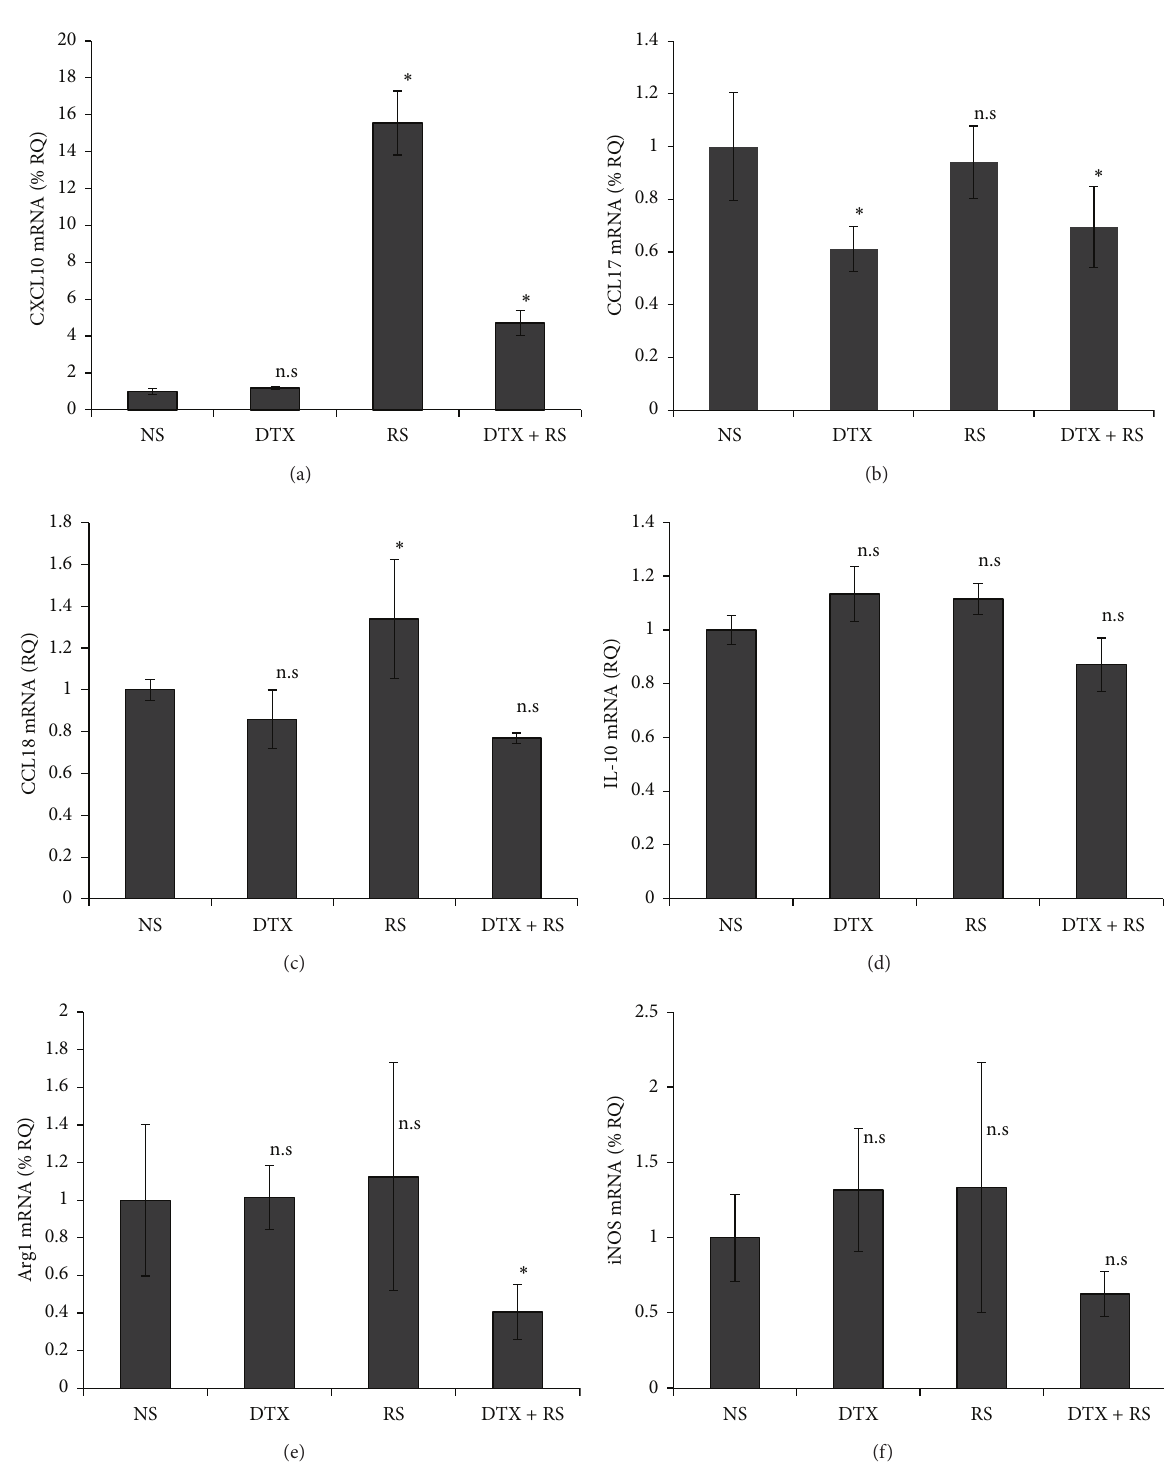
Figure 2: DTX with or without RS effects on the mRNA expression by M2 macrophages. M2 macrophages from PBMCs were stimulated by DTX and/or RS. Six hours after stimulation, total RNA was recovered from these cells and then reverse transcribed into cDNA. The viability of cells 6 hours after stimulation is 95% ∼ 98% in each group. Quantitative real-time PCR was conducted to determine the number of copies of cDNA for each chemokine, Arg1, and iNOS and the relative mRNA expression levels were calculated for each gene and each time point after normalization against GAPDH using the ΔΔ Ct method. The data from each donor were obtained by the triplicated assays, and then the mean ± SD was calculated. Representative data from three different donors are